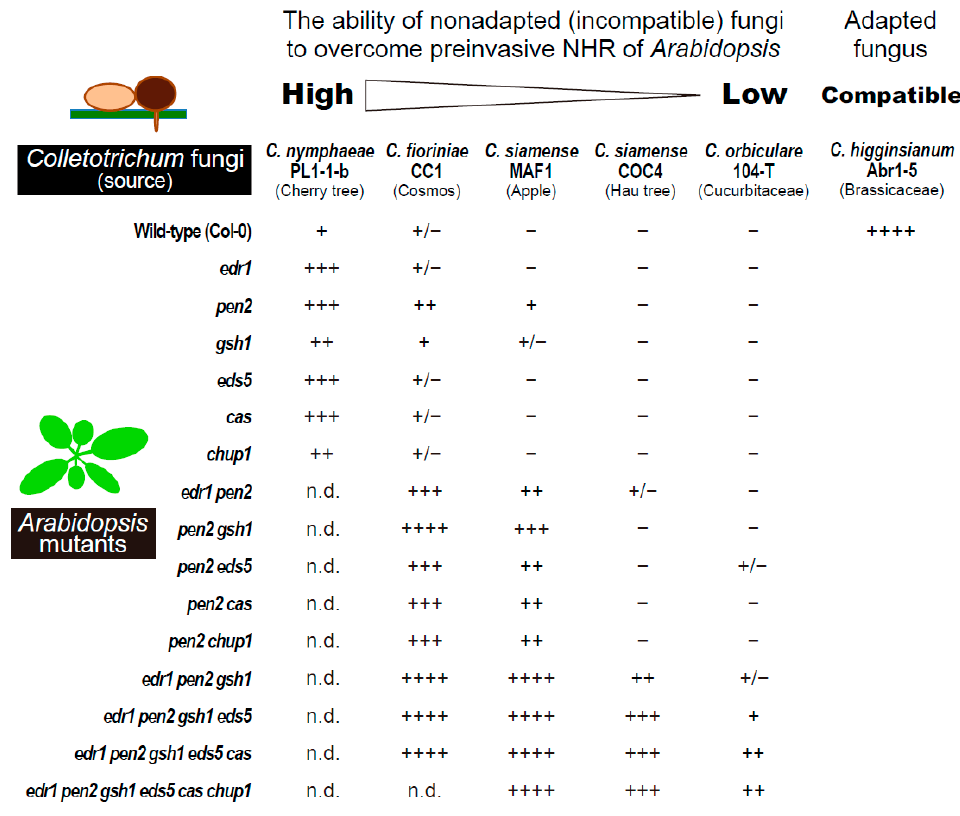
Figure 2. Relationships between nonadapted Colletotrichum fungi and preinvasive nonhost re- sistance (NHR) in A. thaliana . Invasion abilities of C. nymphaeae PL1-1-b (MAFF240037), C. fioriniae CC1 (MAFF306550), C. siamense MAF1 (MAFF243010), COC4 (MAFF243696), and C. orbiculare 104-T (MAFF240422) into